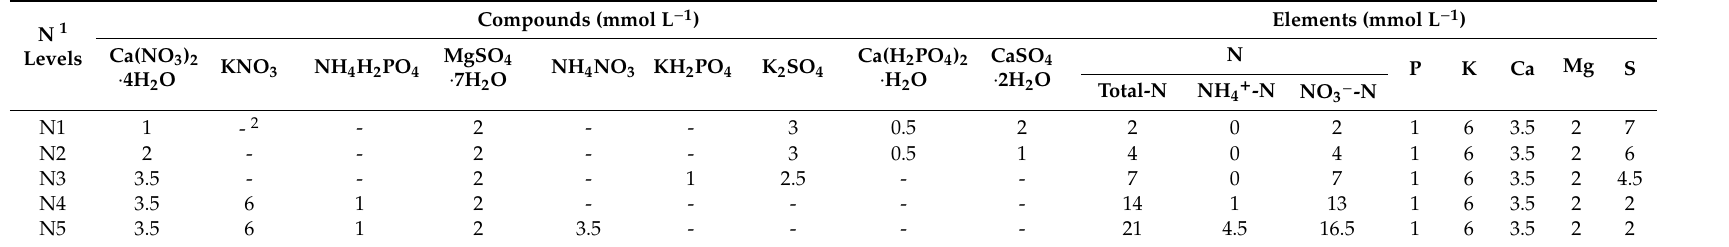
Table 1. Components of macro-nutrient solutions in di ff erent N